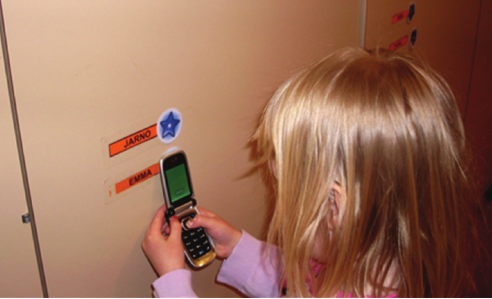
Figure 15: A girl touching a “Star” icon. The phone says out loud the name of the child written in the